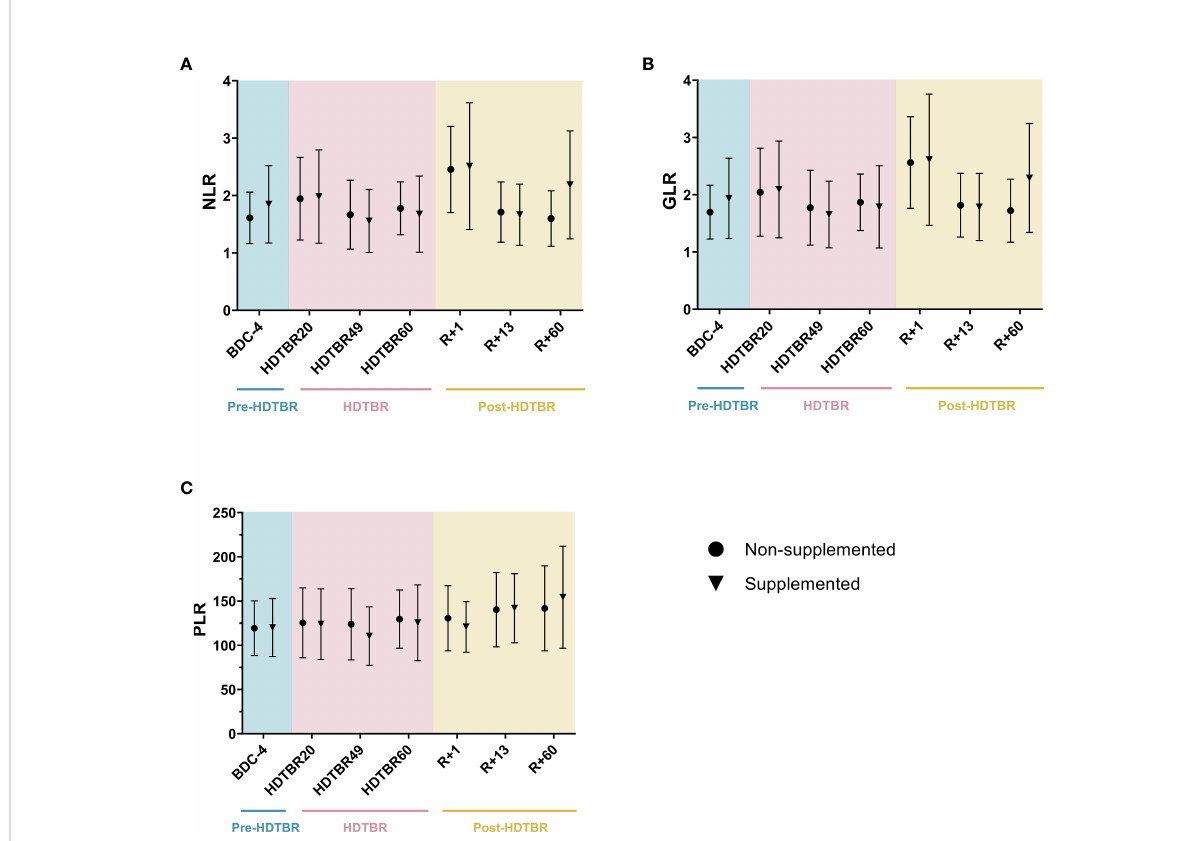
FIGURE 2 Comparison of NLR (A) , GLR (B) and PLR (C) ratios between the supplemented and non-supplemented groups at each time point of the head- down tilt bed rest study. Dots and triangles indicate the mean ± SD. n=10 in the supplemented group. n=10 in the non-supplemented group, except at R+60, where n=7. No statistically signi fi cant differences between the supplemented and non-supplemented groups were observed at any time point for any ratio using two-way ANOVAs, indicating that individuals of both groups could be pooled. BDC, baseline data collection (blue); HDTBR, head-down tilt bed rest (pink); R, recovery